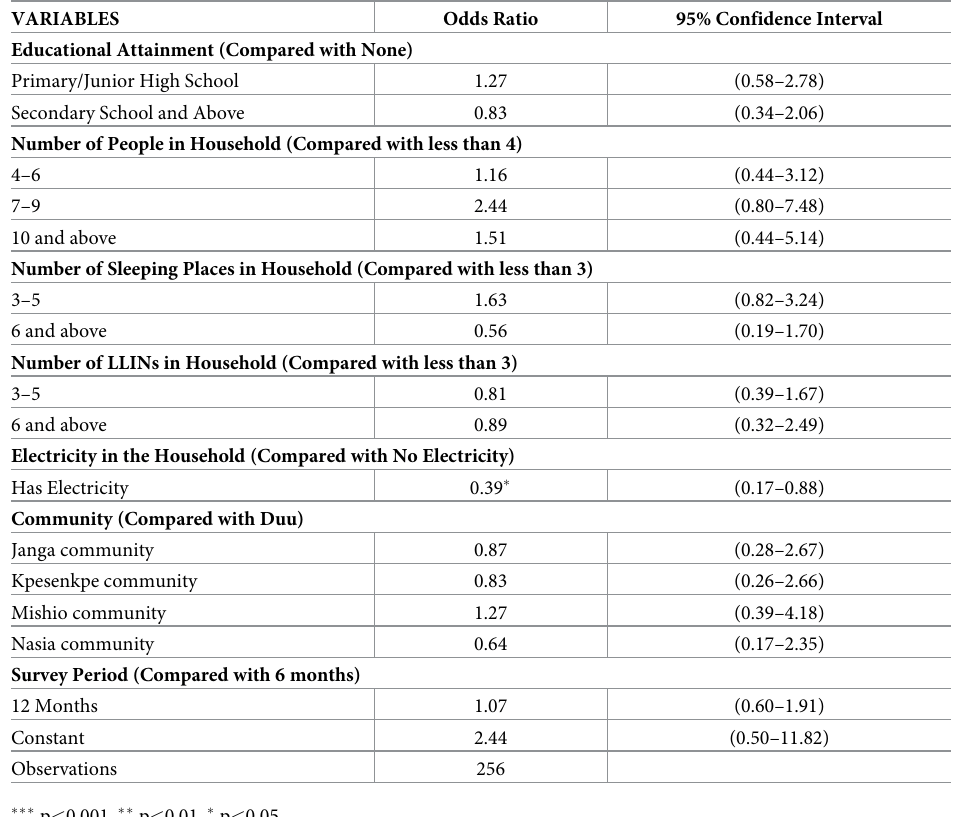
Table 3. Logistic regression of factors associated with LLIN